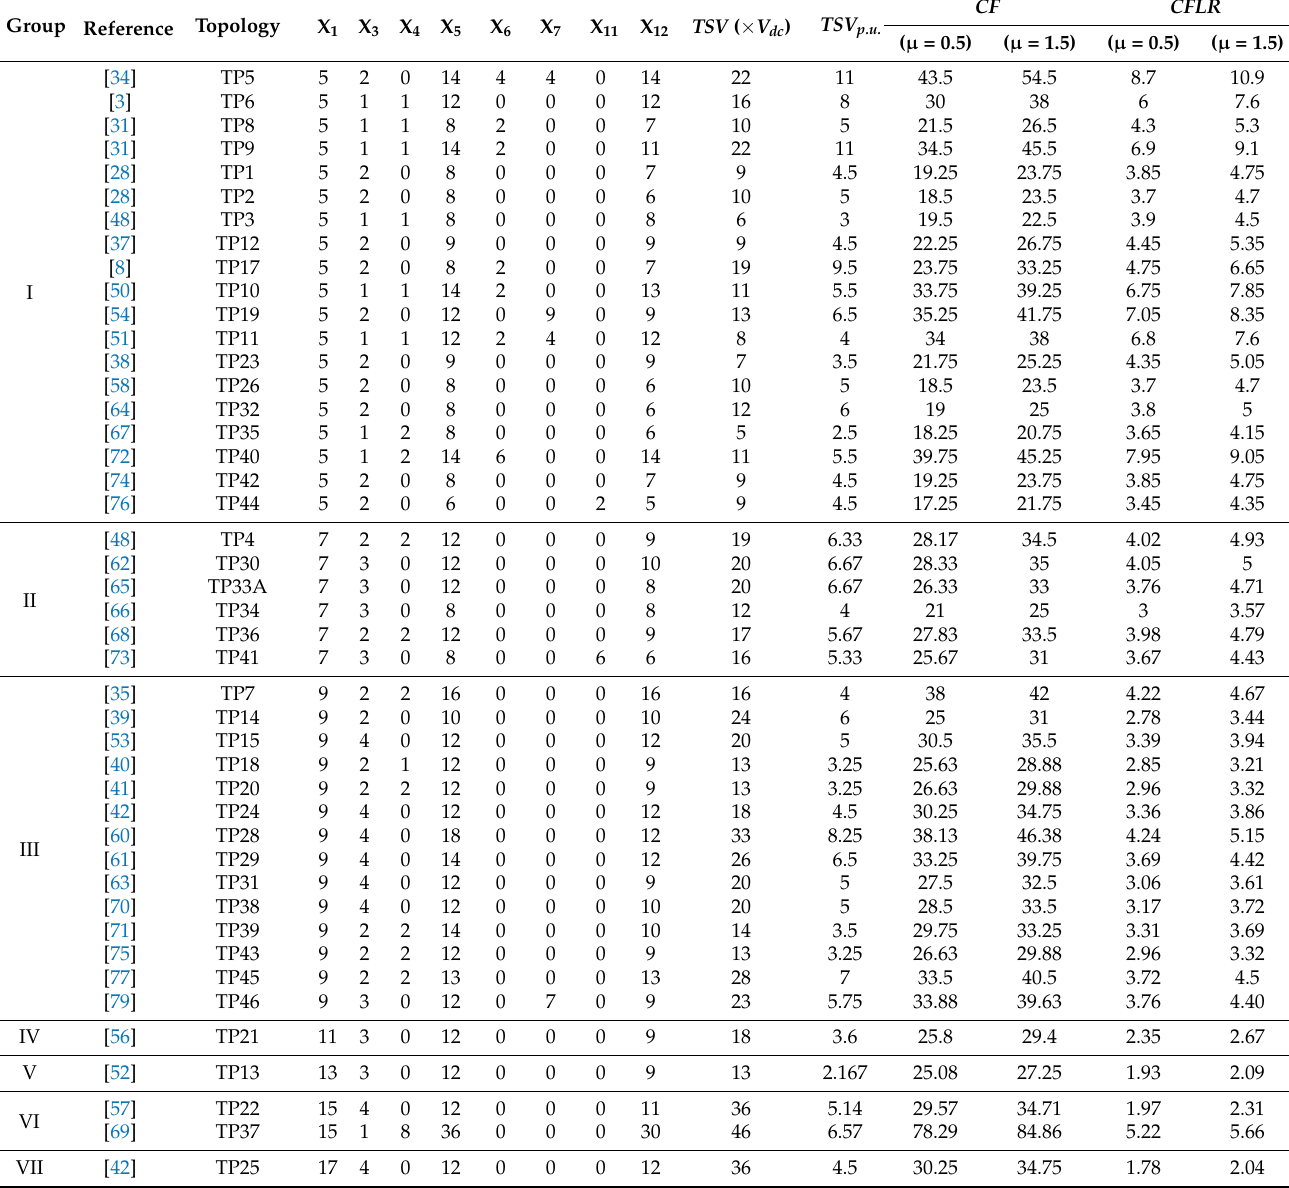
Table 3. Comparison of single-phase FT MLIs in terms of TSV , CF , and CFLR .